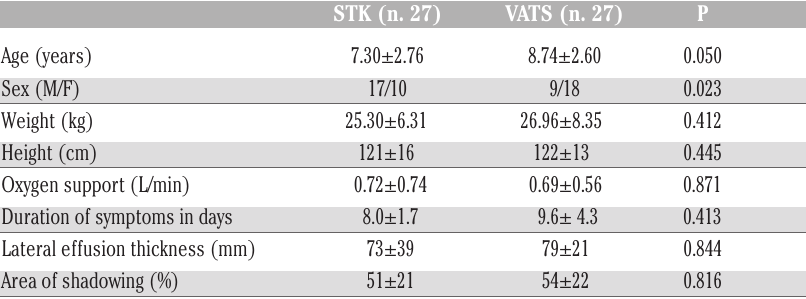
Table 1. Patients’ characteristics at diagnosis.